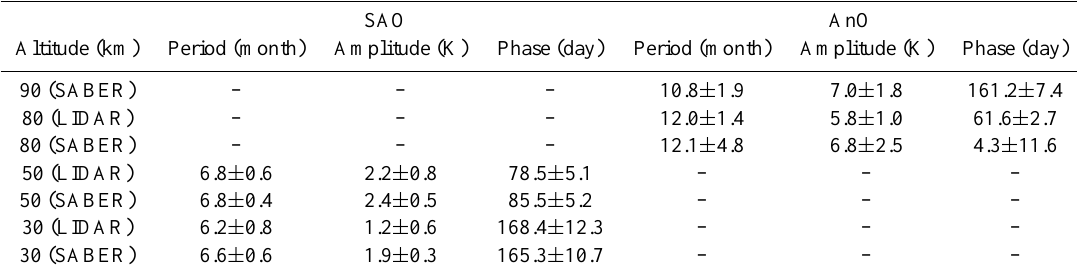
Table 1. Wave parameters derived after best sinusoidal fit to SABER and lidar data.